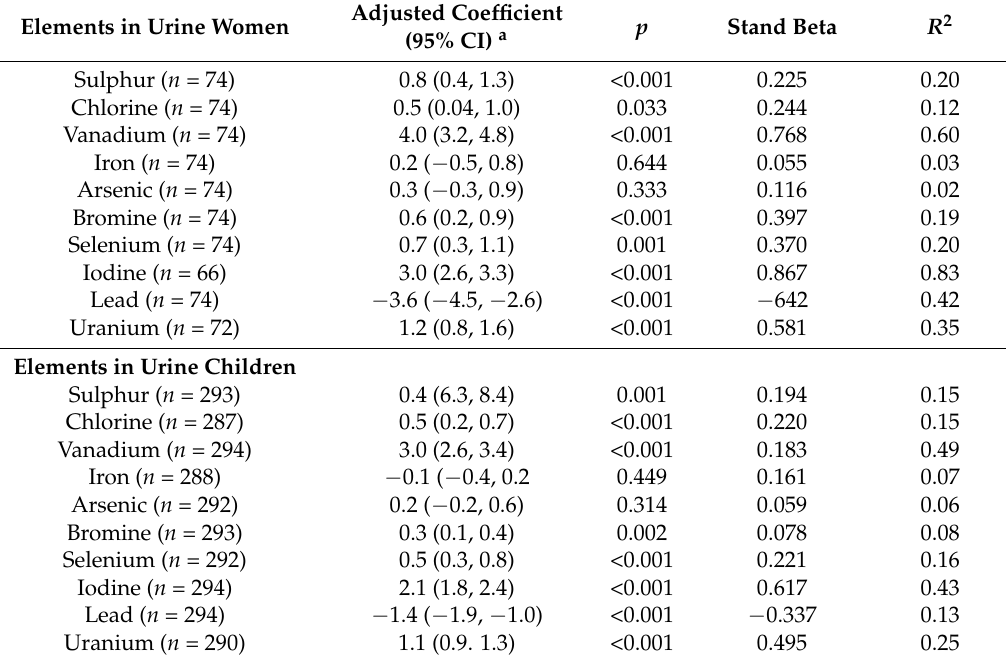
Table 6. Concentration of different chemical elements in urine among women and children in association with zones.